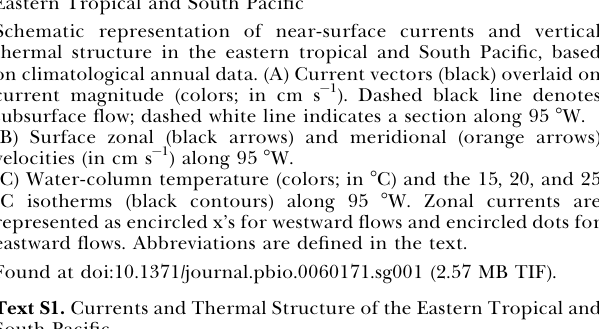
Figure S1. Surface Currents and Vertical Thermal Structure in the Eastern Tropical and South Pacific Schematic representation of near-surface currents and vertical thermal structure in the eastern tropical and South Pacific, based on climatological annual data. (A) Current vectors (black) overlaid on current magnitude (colors; in cm s (cid:2) 1 ). Dashed black line denotes subsurface flow; dashed white line indicates a section along 95 8 W. (B) Surface zonal (black arrows) and meridional (orange arrows) velocities (in cm s (cid:2) 1 ) along 95 8 W. (C) Water-column temperature (colors; in 8 C) and the 15, 20, and 25 8 C isotherms (black contours) along 95 8 W. Zonal currents are represented as encircled x’s for westward flows and encircled dots for eastward flows. Abbreviations are defined in the